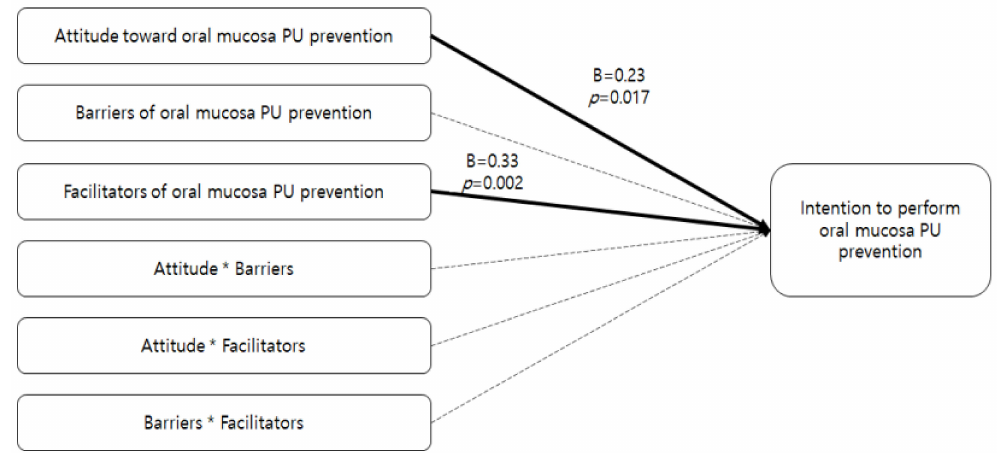
Figure 1. Diagram for results of multiple